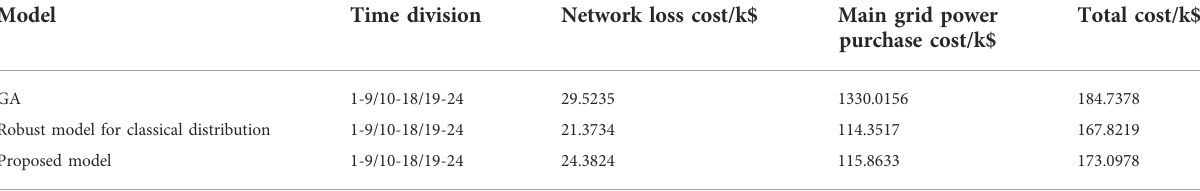
TABLE 7 Comparison of economic parameters.